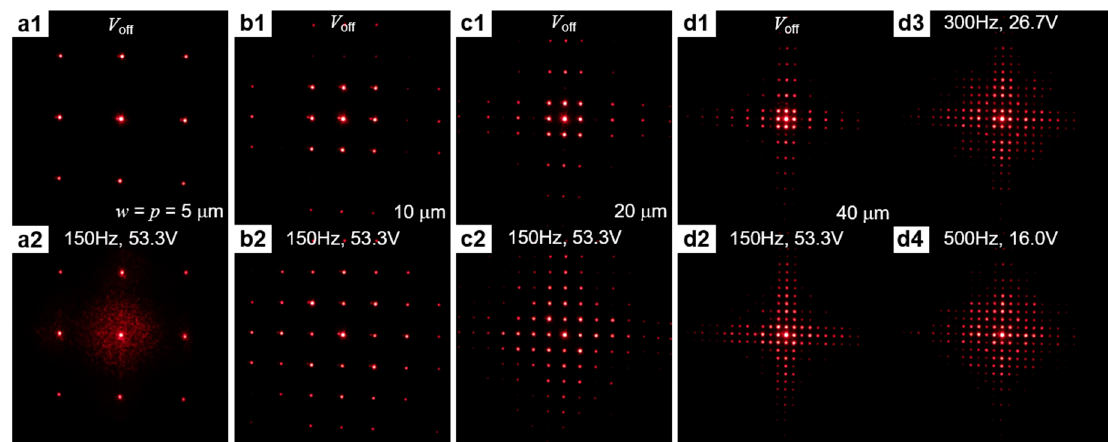
Figure 7. Effect of cell thickness on the defect formation with respect to pillar width w and pillar Figure 8. Diffraction patterns with square-shaped pillars: ( a ) w = p = 5; ( b ) w = p = 10; ( c ) w = p = 20; spacing p : ( a ) w = p = 5 μ m; and ( b ) w = p = 10 μ m. Cell thickness d = 11 μ m, pillar height h = 2 μ m. P, and ( d ) w = p = 40 μ m. ( a1–d1 ) Voltage-off state; ( a2–d2 ) f = 150 Hz, V = 53.3 V; (d3) f = 300 Hz, V = 26.70 polarizer; A, analyzer; λ , full-wave plate. V; and ( d4 ) f = 500 Hz, V = 16.0 V. Cell thickness is d = 5.6 μ m and pillar height is h = 2 μ m.